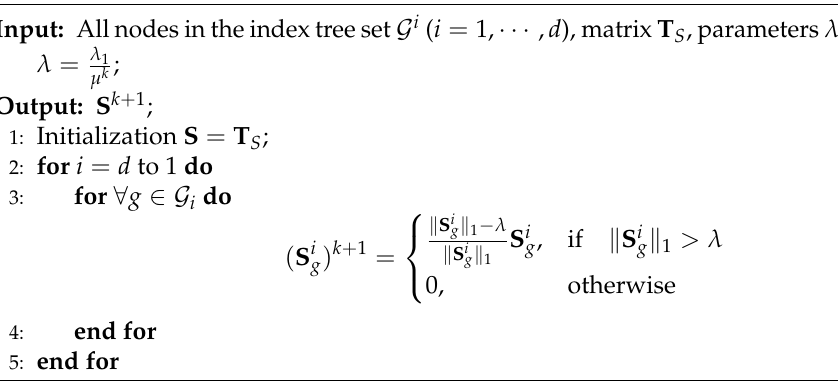
Algorithm 2 Update of the algorithm steps of